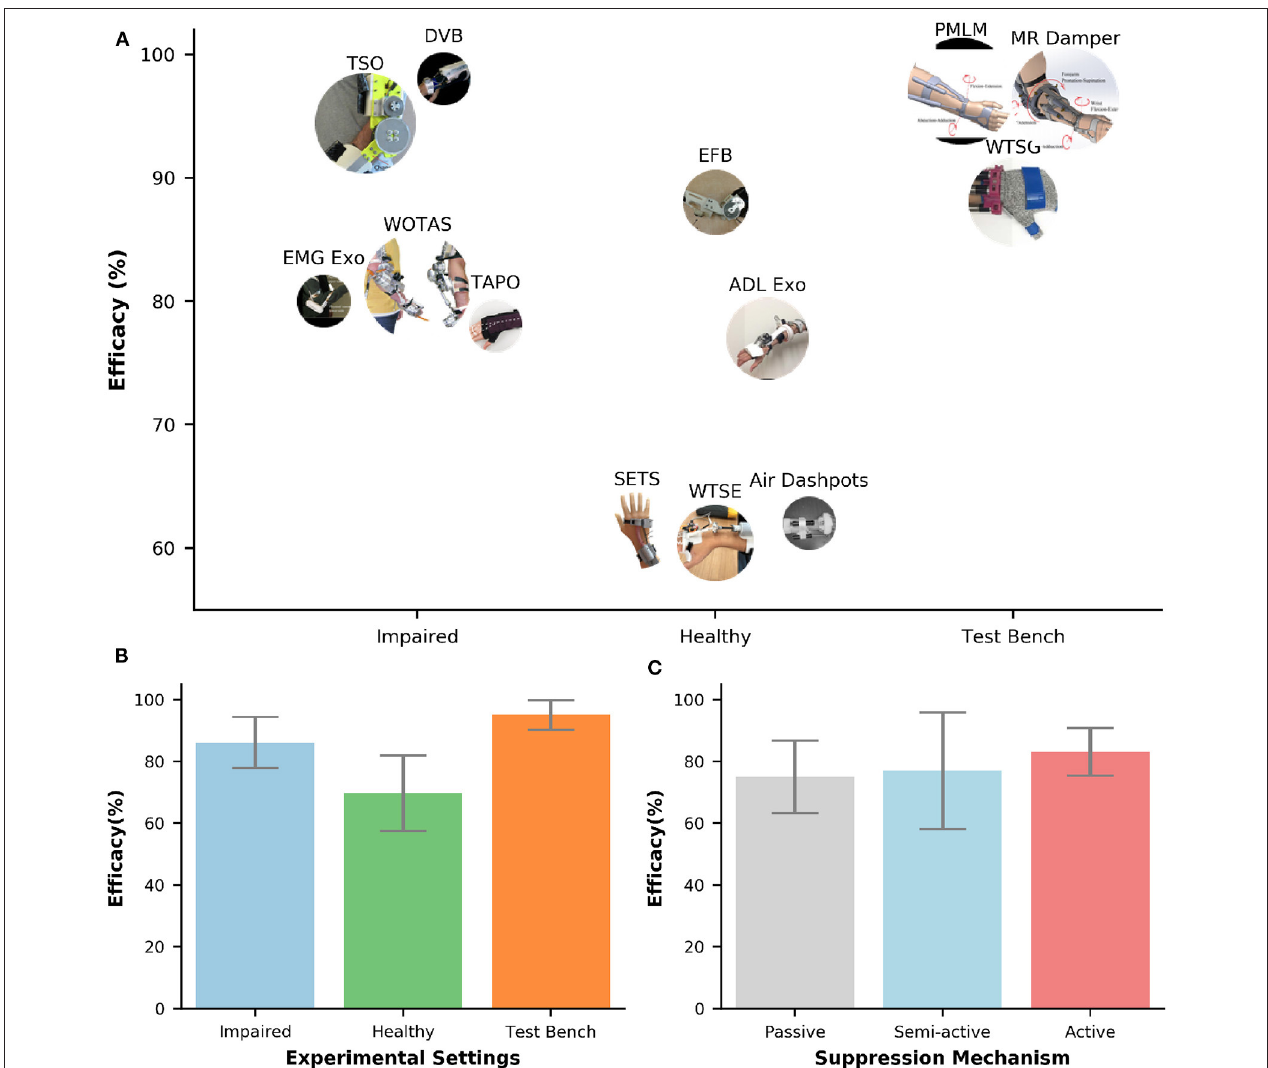
FIGURE 5 | (A) Efficacy of tremor-suppression orthoses under different types of experimental setups (bench test, healthy, and impaired). The circle’s size represents the number of participants. (B,C) Bar plots of efficacy against experimental settings and suppression mechanisms, respectively. The error bars represent one standard